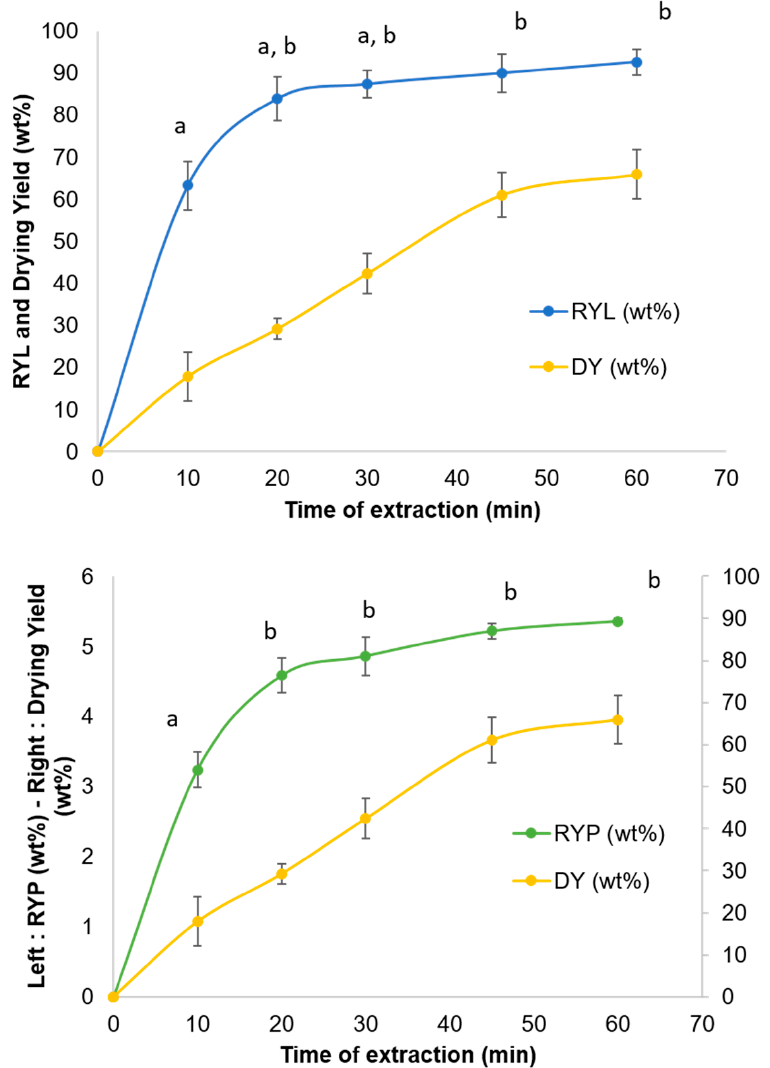
Figure 6. Extraction kinetic for RYL ( top ) and RYP ( bottom ) in optimized conditions (265 bars, 55 °C, 55 wt% moisture content). Values marked by the same letters are not significantly different according to the Student test ( p < 0.05).